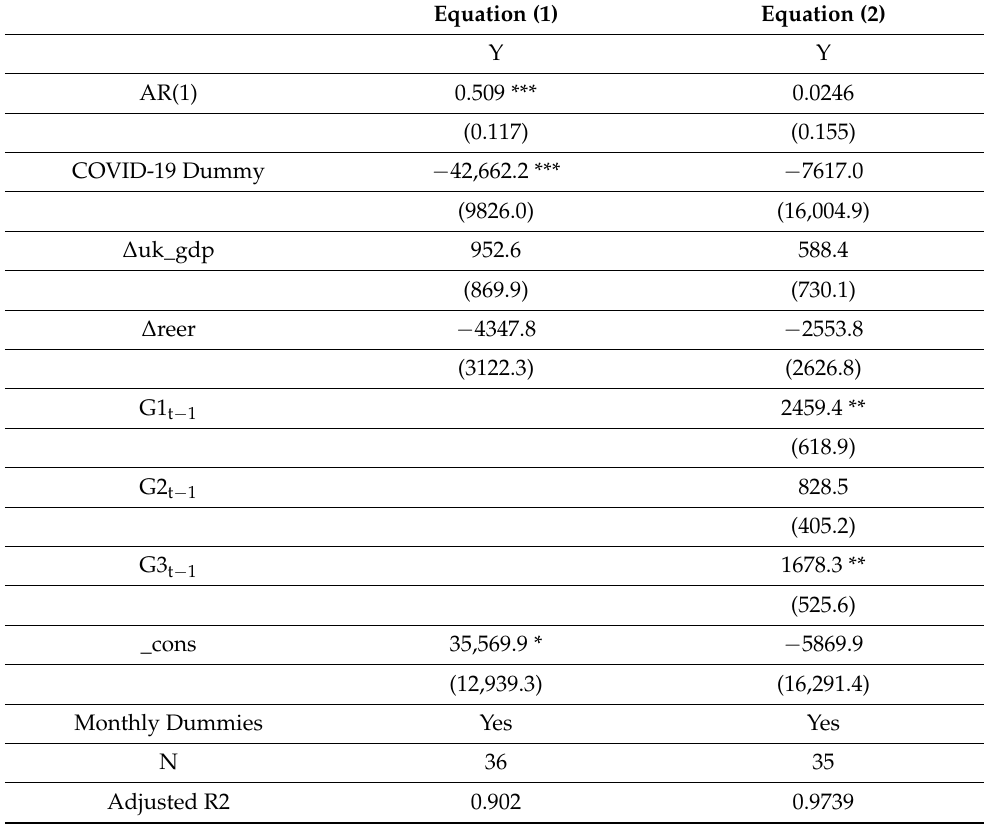
Table 1. Regression